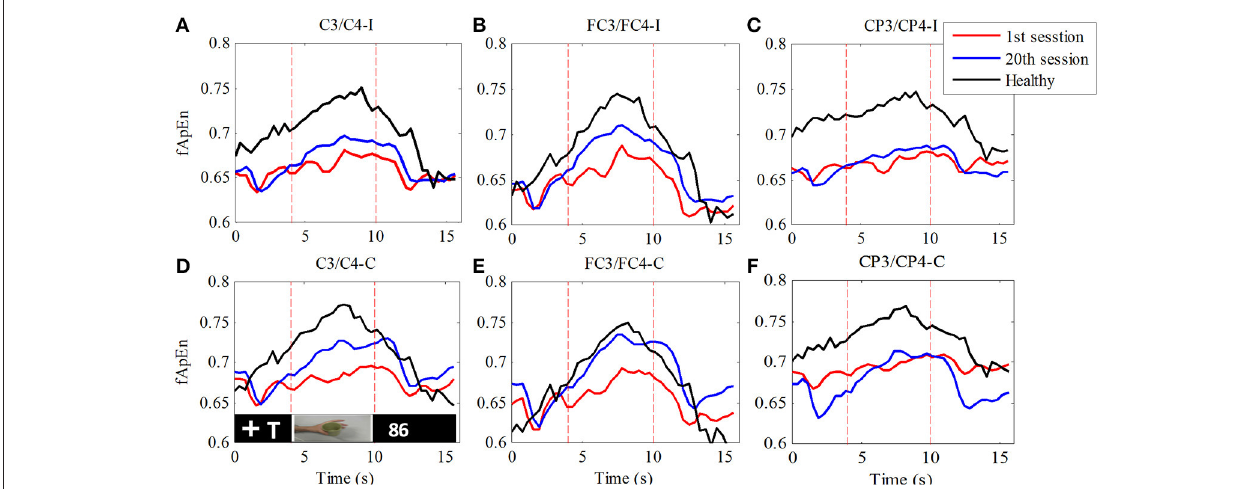
FIGURE 6 | Comparison of fApEn during observation of biological movement at six electrodes ( A , C3/C4-ipsilesional; B , FC3/FC4-ipsilesional; C , CP3/CP4- ipsilesional; D , C3/C4-contralesional; E , FC3/FC4-contralesional; F , CP3/CP4-contralesional) among healthy participants and stroke participants, pre- and post-training.